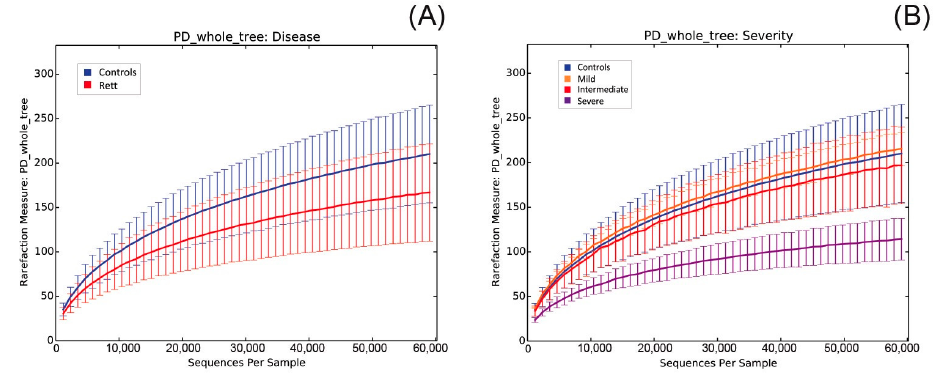
Figure 1. α rarefaction curves according to Faith’s phylogenetic diversity index. ( A ) α -diversity plot of Rett (red) versus control (blue) samples. RTT patients show a reduced biodiversity compared to healthy controls. Differences are not statistically significant ( p > 0.05); ( B ) Data grouped according to disease severity. Severe stage (purple) samples show a reduced biodiversity compared to healthy controls (blue), mild (orange), or intermediate (red) disease stage. Differences are not statistically significant ( p > 0.05).